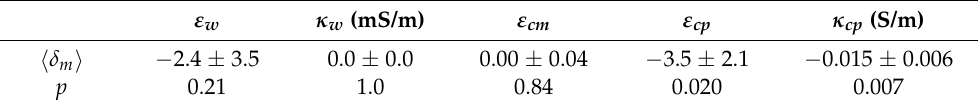
Table 2. Average difference between electrical phase parameters, plus or minus one standard deviation (n = 5 experiments), along with the p -value obtained by applying a paired Student’s t -test to pairs of Ste2 ∆ cell suspensions, one with and one without α -factor added to it. ε w κ w